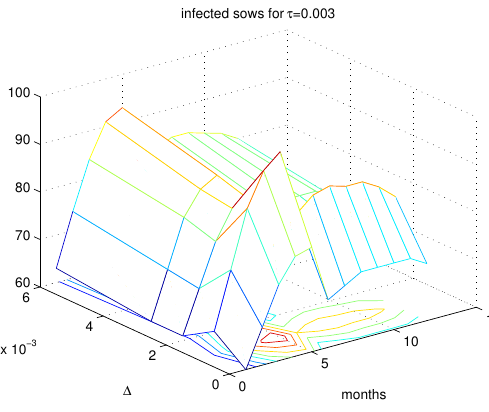
Fig. 5 Infected sows evolution during a whole year. Here we fix the value of external contamination rate at τ = 0 . 003.